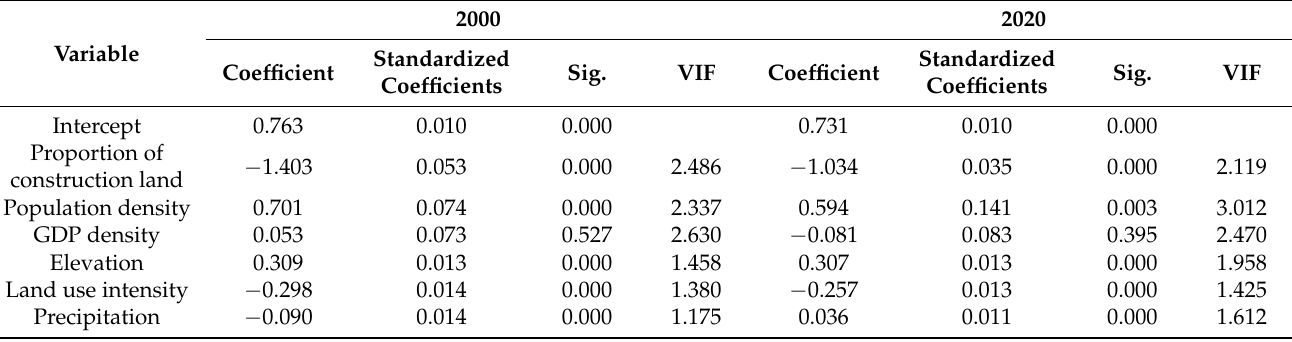
Table 2. Result of the OLS model at 10 km grid